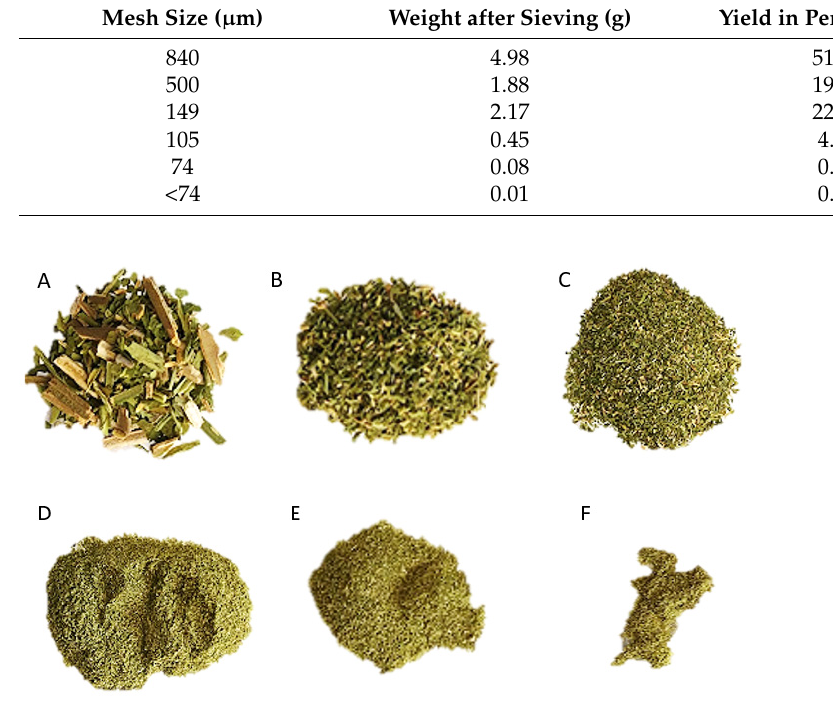
Figure 4. N. tabacum var. Virginia leaf waste powder. Sieved fractions from ground leaf waste. ( A ) 840 µm. ( B ) 500 µm. ( C ) 149 µm. ( D ) 105 µm. ( E ) 74 µm. ( F ) <74 µm.